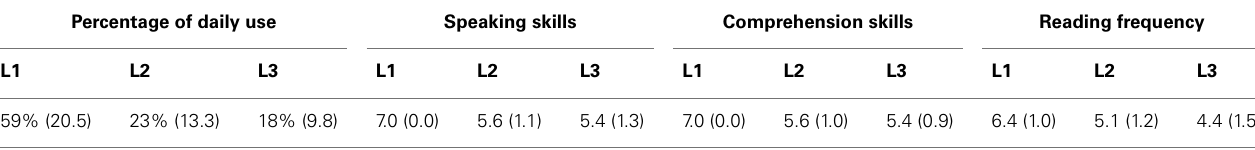
Table 1 | Summary of participants’ language skills and relative use of each